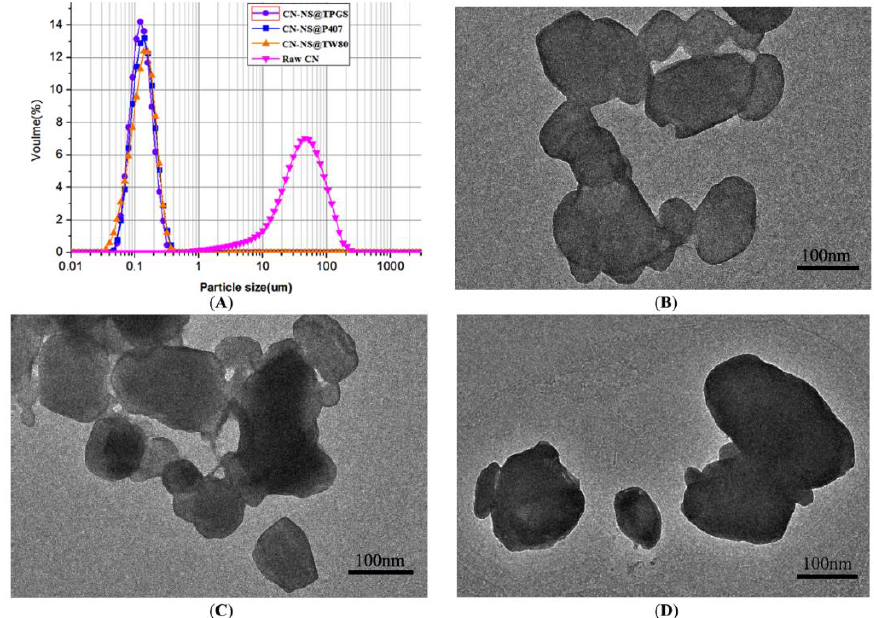
Figure 2. The particle sizes ( A ) of the CN-NS modified by different stabilizers, morphology of CN- NS@TPGS ( B ), CN-NS@TW80 ( C ), CN-NS@P407 ( D ).